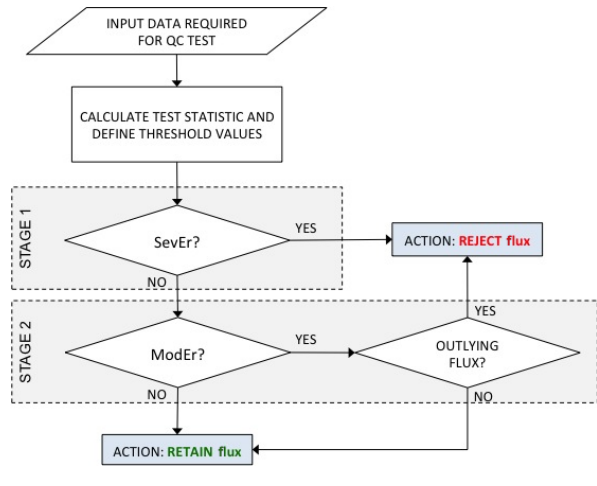
Figure 1. Schematic summary of the proposed data cleaning pro- cedure. SevEr and ModEr indicate strong and weak evidence about the presence of a specific source of systematic error,